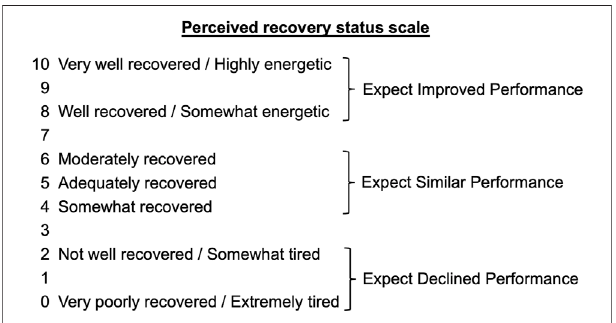
FIGURE 2 | The PRS Scale according to Laurent et al. (Laurent et al., 2011).